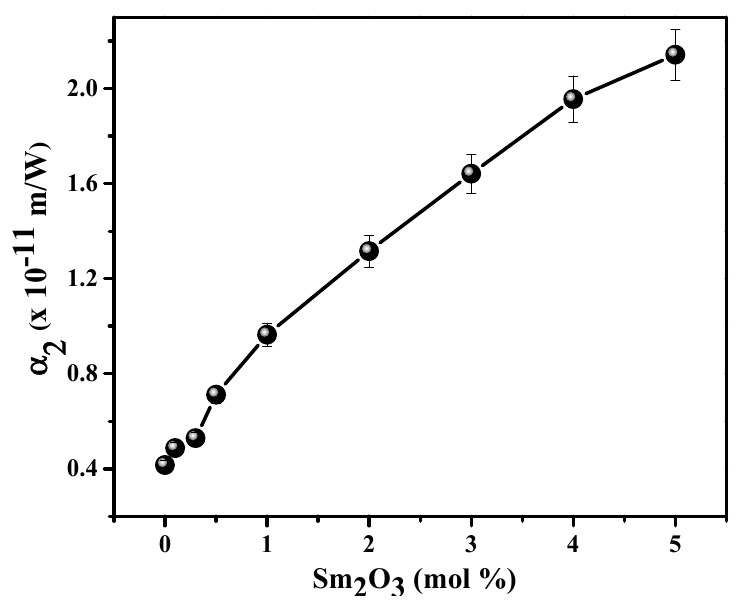
Figure 3. Variation of α 2 with respect to Sm 2 O 3 content in the glass composition.